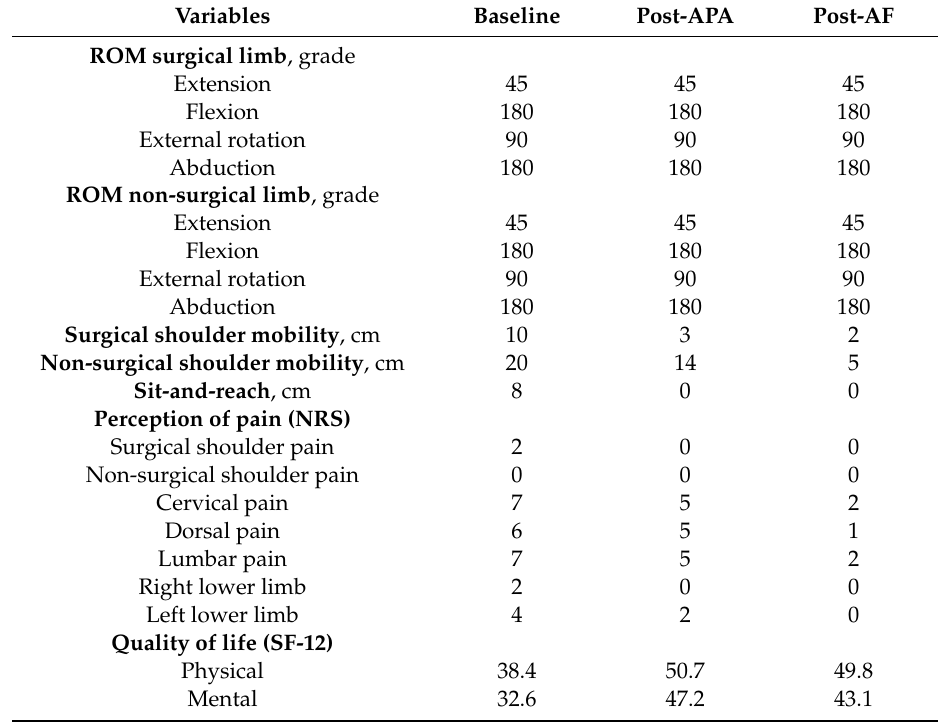
Table 2. Fitness tests, pain intensity and quality of life scores at baseline and after the completion of either adapted physical activity (APA) or adapted fitness (AF) protocols. Variables Baseline Post-APA Post-AF ROM surgical limb , grade Extension 45 45